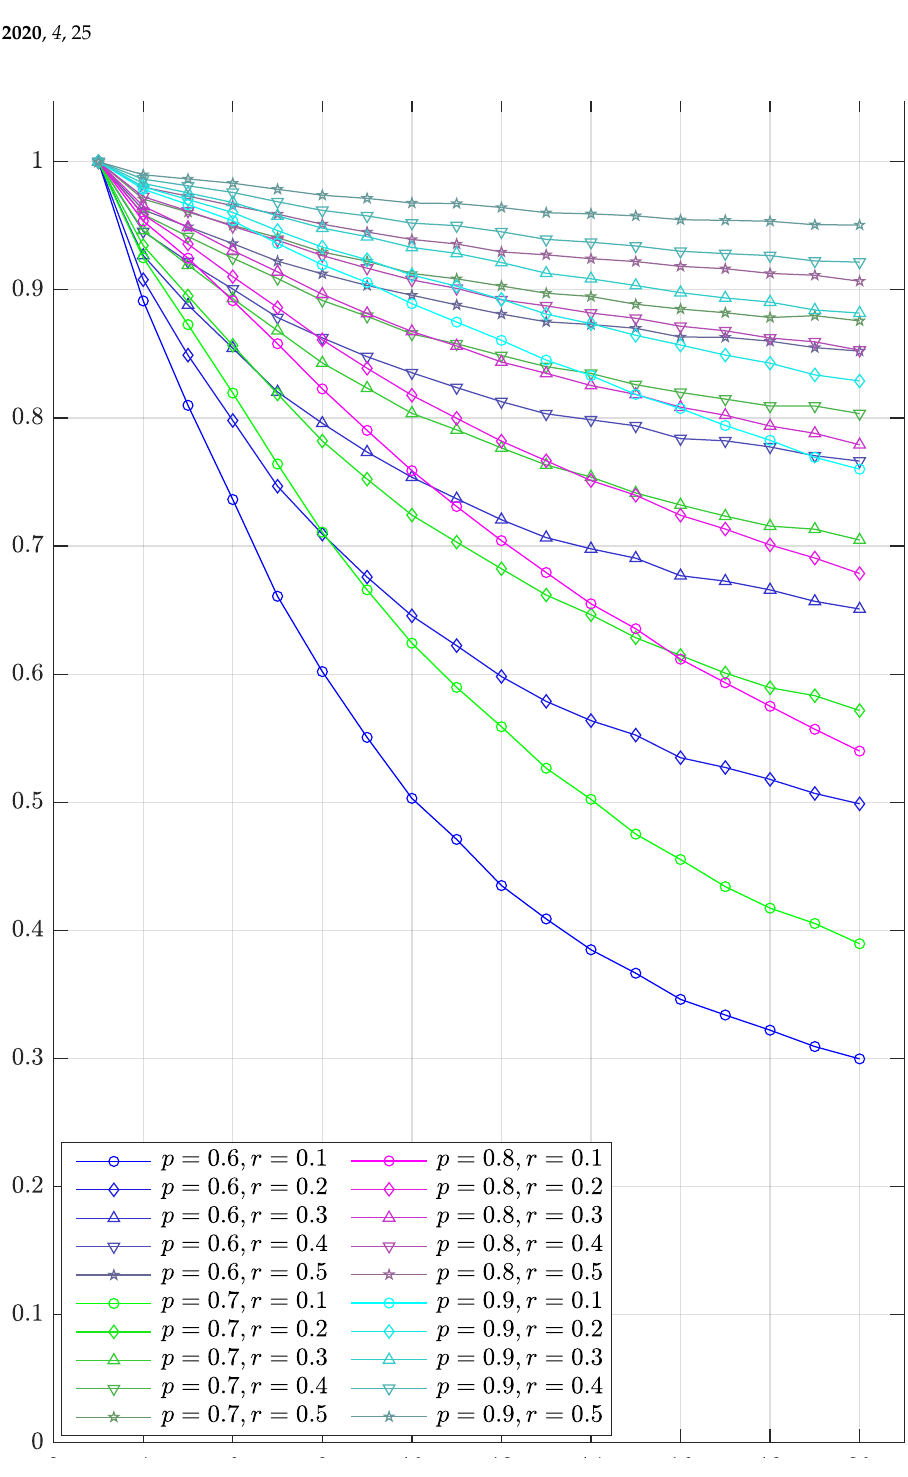
Figure 6. Relative standard deviation (heteroskedastic rms over homoskedastic rms) of the fitted angle φ for all 20 combinations of p and r in the range 3 ≤ n ≤